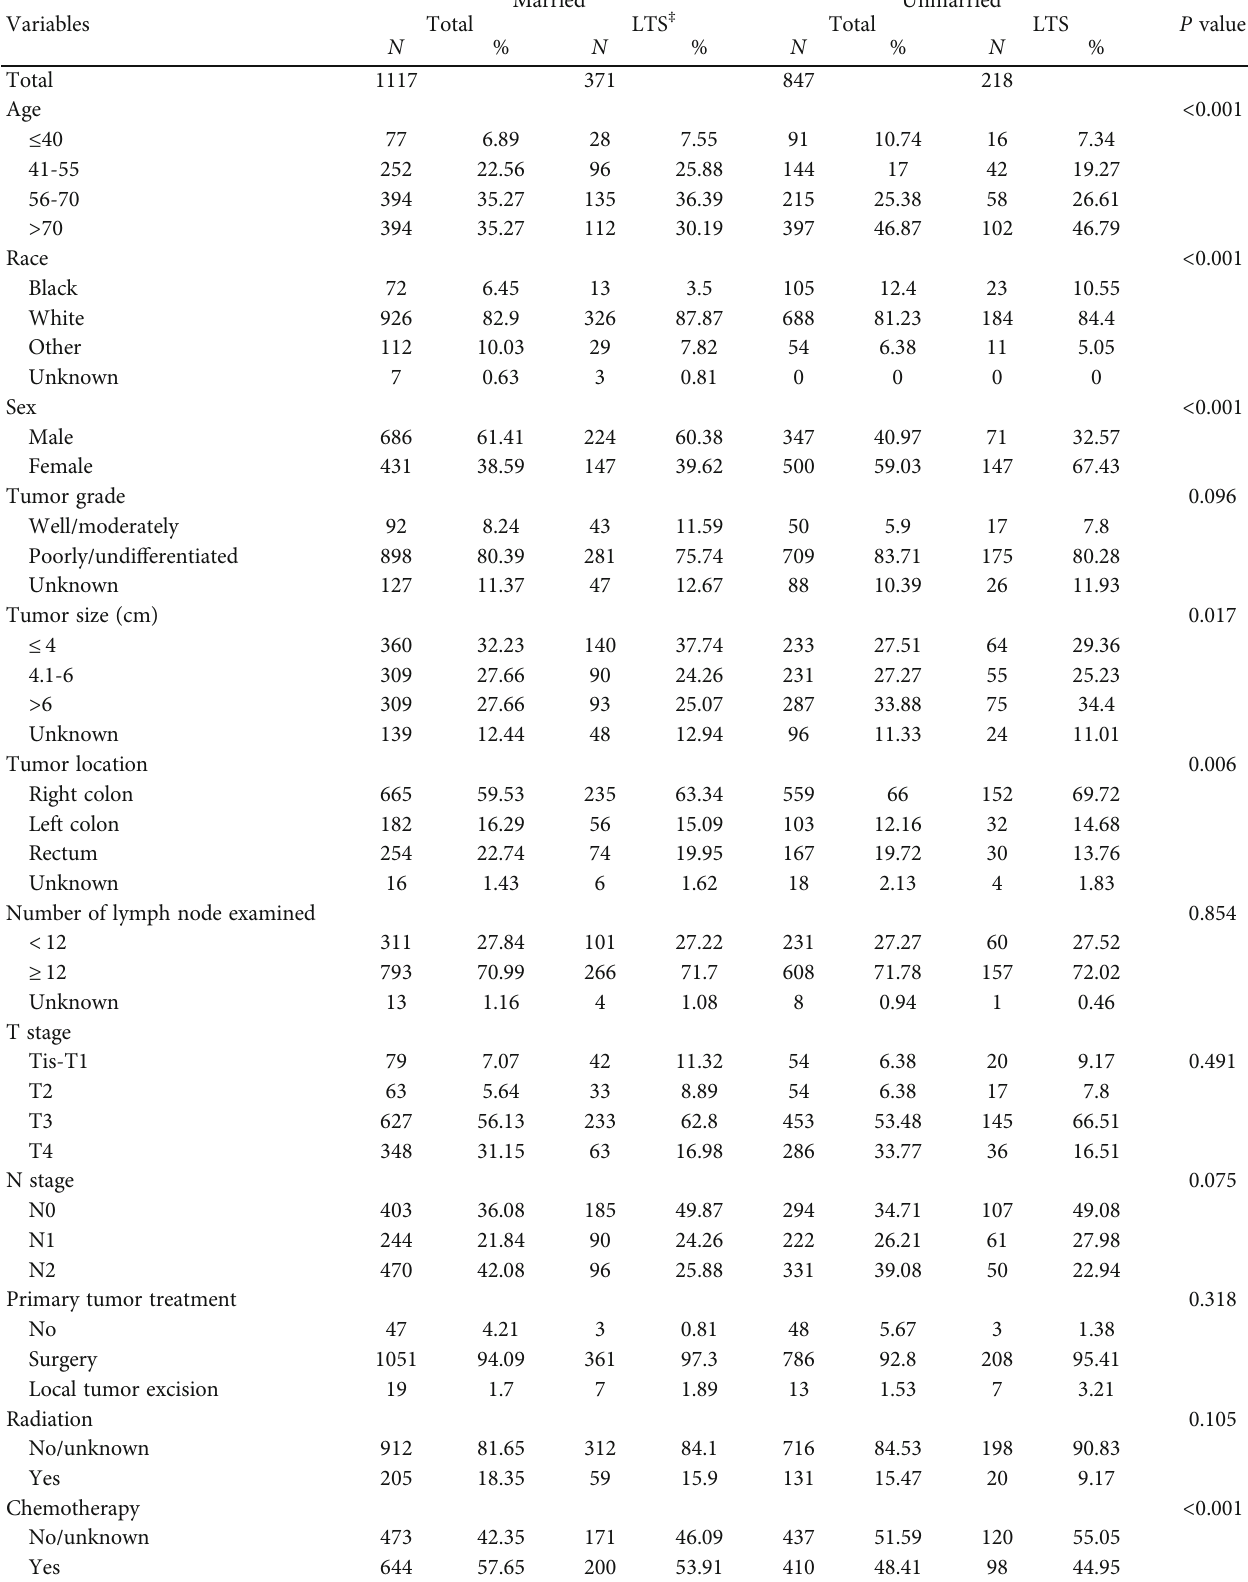
Table 3: The association between marital status and long-time survivors in nonmetastatic colorectal SRCC † .